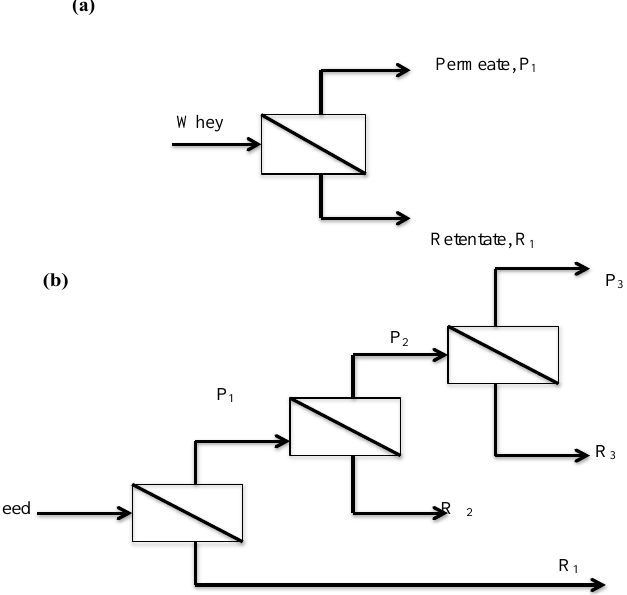
Fig. 5.2. (a) one-stage ultrafiltration system (b) Three-stage rectification system Figure 1. Flow configurations evaluated: ( a ) one-stage concentration, and ( b ) three-stage rectification. The membranes used in Stages 1 to 3 were the same.